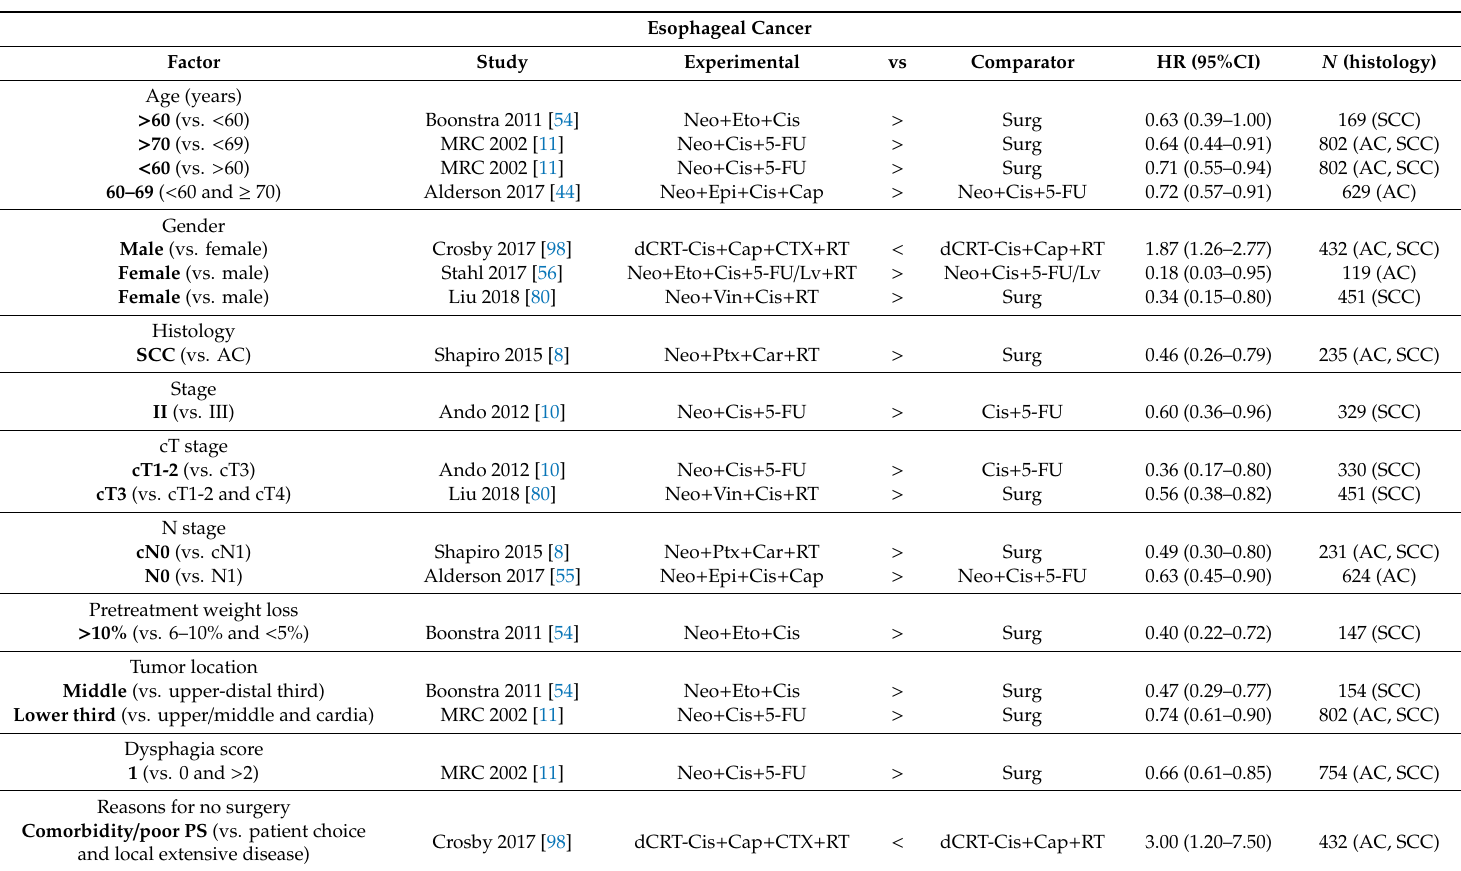
Table 4. Potentially clinically relevant predictive factors for the curative treatment of esophageal cancer. Potentially clinically relevant predictive factors for OS defined as the p -value for subgroup interaction between two or more subgroups should be < 0.20 and the HR of one of the subgroups was statistically significant ( p < 0.05). The greater than ( > ) or smaller than ( < ) symbols indicate which specific treatment showed a significant survival benefit over the other treatment in a specific patient subgroup highlighted in black. Almost all studies investigated the value of neoadjuvant therapy before surgery except for Crosby 2017 which investigated the value of definitive chemoradiotherapy and Ando 2012 compared neoadjuvant to adjuvant